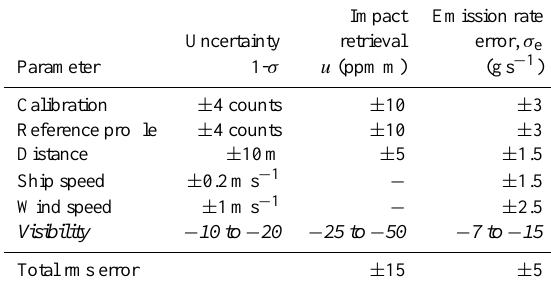
Table 3. Main sources of error in the retrieval of SO 2 path concen- tration and emission rate from the UV camera. Note that the errors due to visibility have not been included in the final error budget. In practice this error is difficult to characterise and so only data where the visibility is good have been used. Averaging of 10–20 frames is performed in the data analysis and this has the tendency to reduce errors due to noise and atmospheric variability.